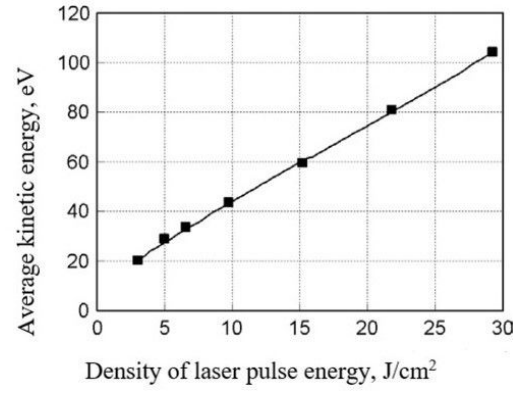
Figure 1: The average kinetic energy of carbon atoms and ions removed from a graphite target as a function of the energy density of the laser pulse (calorimetric measurement)